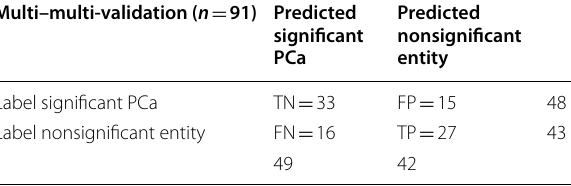
Table 3 Confusion matrix for the multi–multi-validation